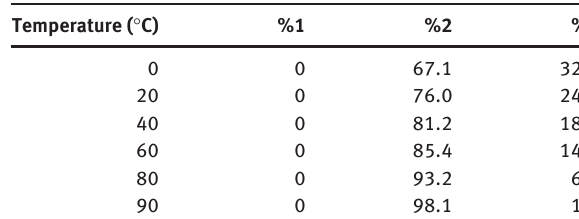
Table 1 Effect of temperature on conversion of 1 into 2 in anhydrous chlorobenzene (no presence of compound 1